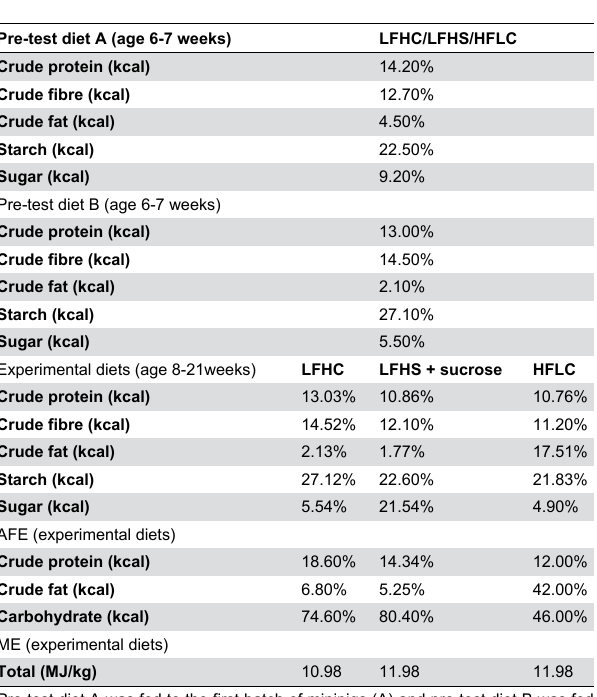
Table 1. Pre-test diets and experimental